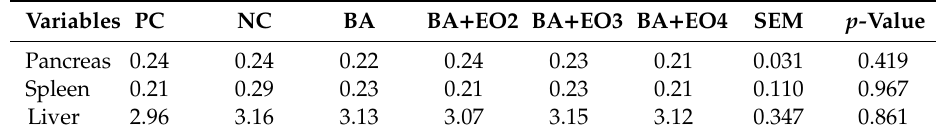
Table 7. E ff ect of experimental diets on the relative weight of organs (%) in piglets challenged with E. coli